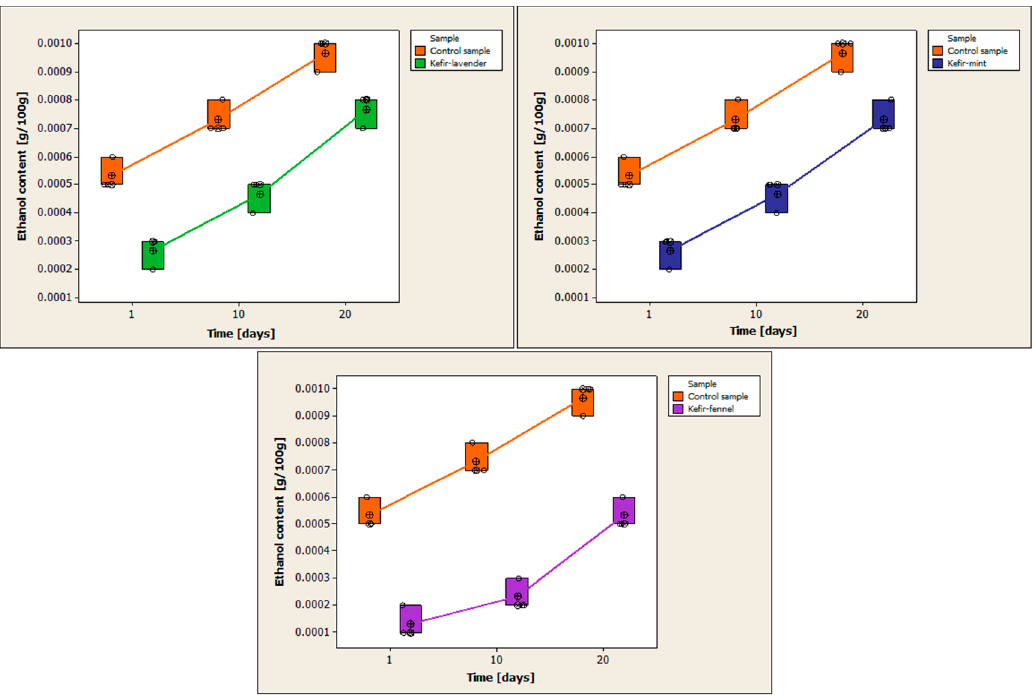
Figure 8. Comparative variation of ethanol content determined by the enzymatic method in kefir samples with encapsulated volatile oils and the control sample.